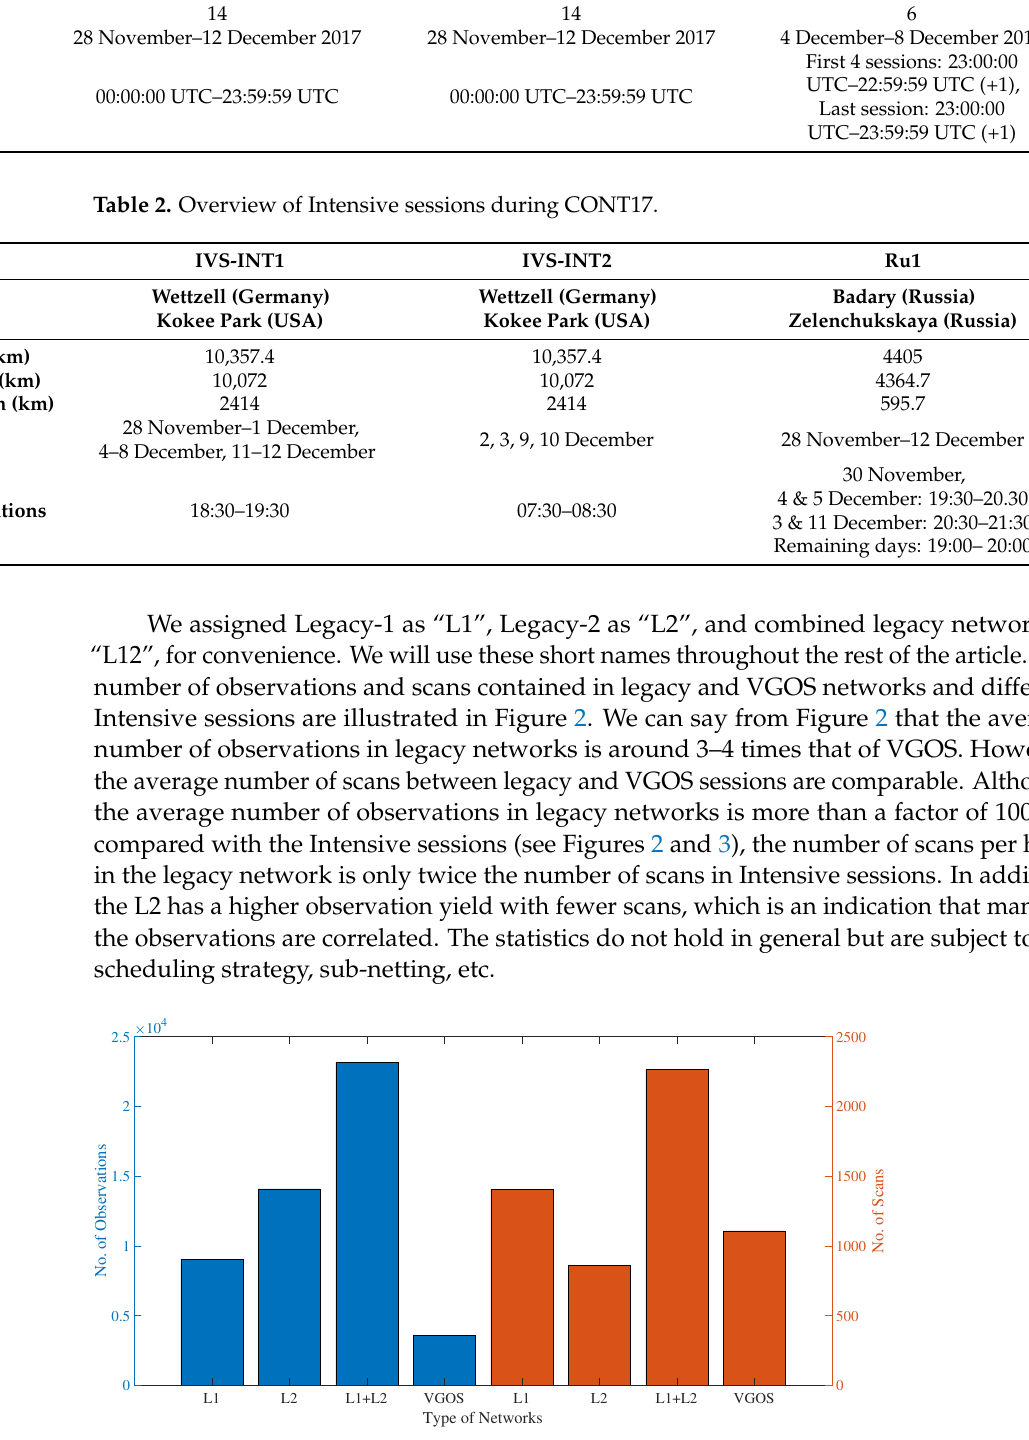
Figure 2. The number of VLBI observations and scans during the CONT17 campaign for 24 h sessions. The y -axis ( left ) represents number of observations, and the y -axis ( right ) represents number of scans (VGOS number of scans is in between L1 and L2 as it is not yet fully